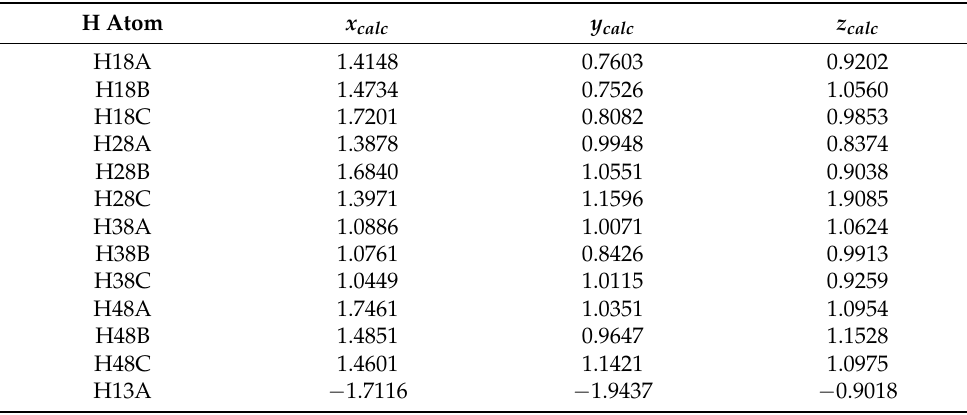
Table 8. Optimized atomic positions of hydrogen atoms in TMA cations in the L